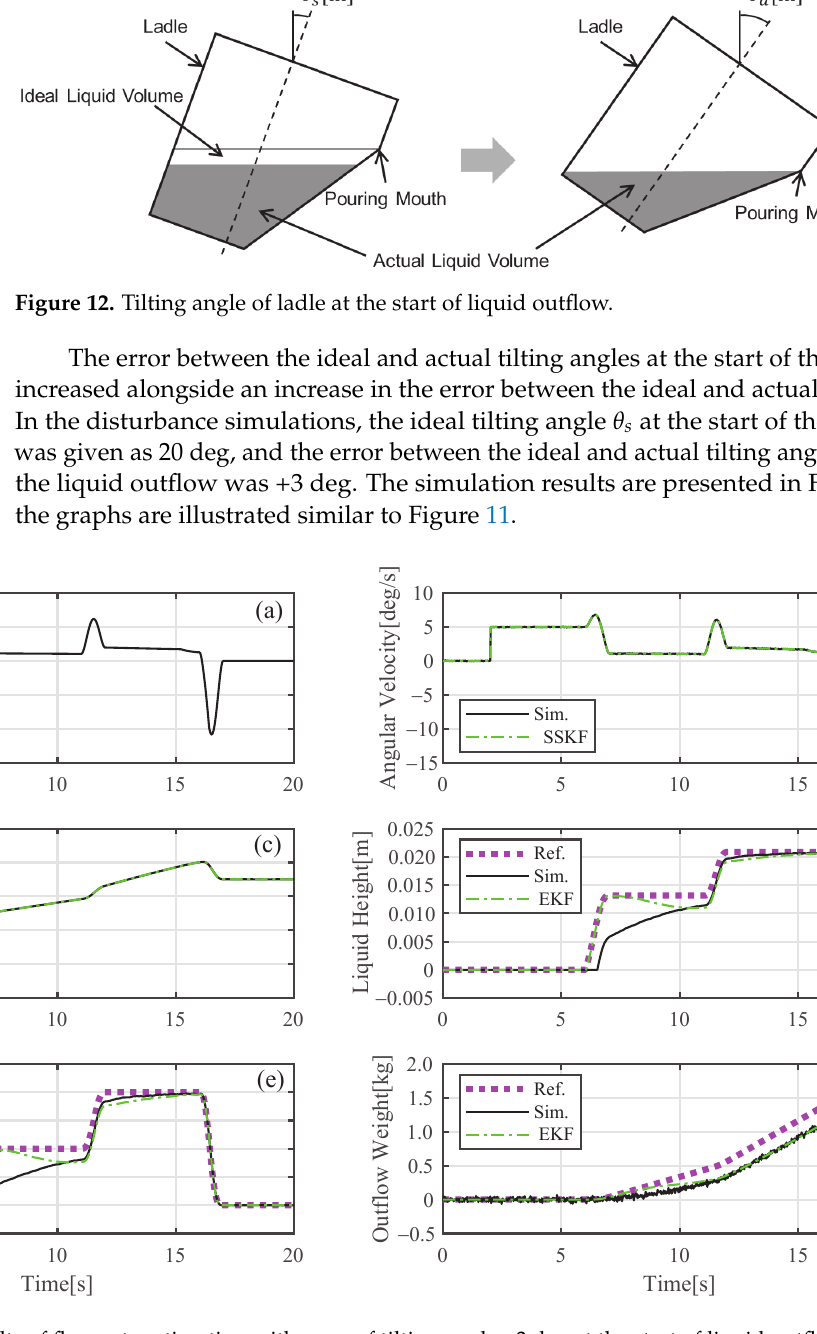
Figure 13. Simulation results of flow rate estimation with error of tilting angle +3 deg at the start of liquid outflow. ( a ) Input command to motor for tilting ladle; ( b ) Angular velocity of tilting ladle; ( c ) Angle of tilting ladle; ( d ) Liquid height on pouirng mouth; ( e ) Flow rate of outflow liquid from ladle; ( f ) Weight of outflow liquid from